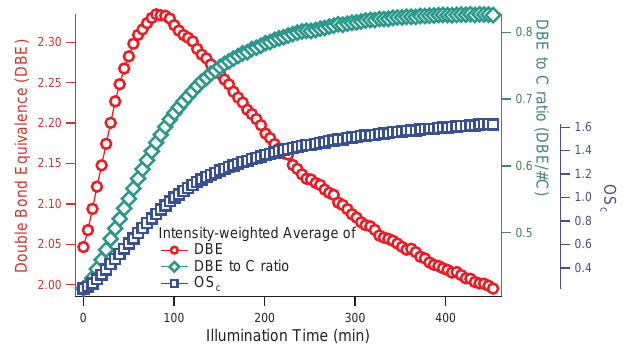
Figure 6. Intensity-weighted average of double bond equivalence (DBE), DBE-to-carbon ratio (DBE / #C), and oxidation state (OS c ) as a function of irradiation